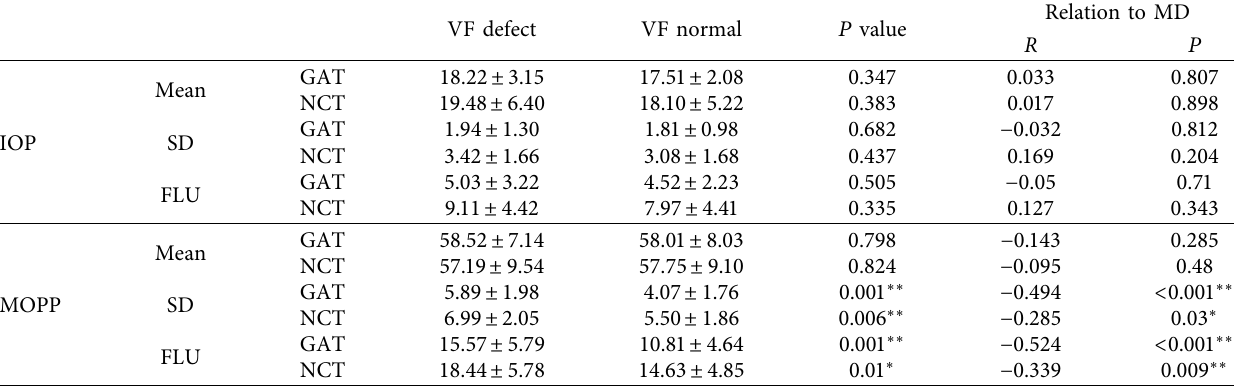
Table 3: Relationship between 24-hour IOP/MOPP measured by the two tonometers and the MD value of